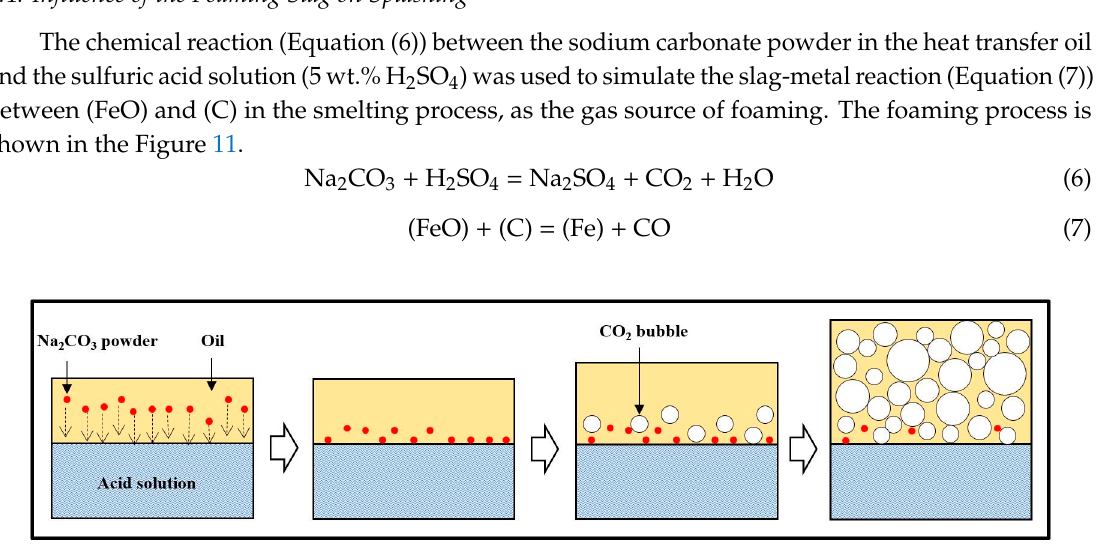
Figure 11. Schematic diagram of the slag foaming simulation.